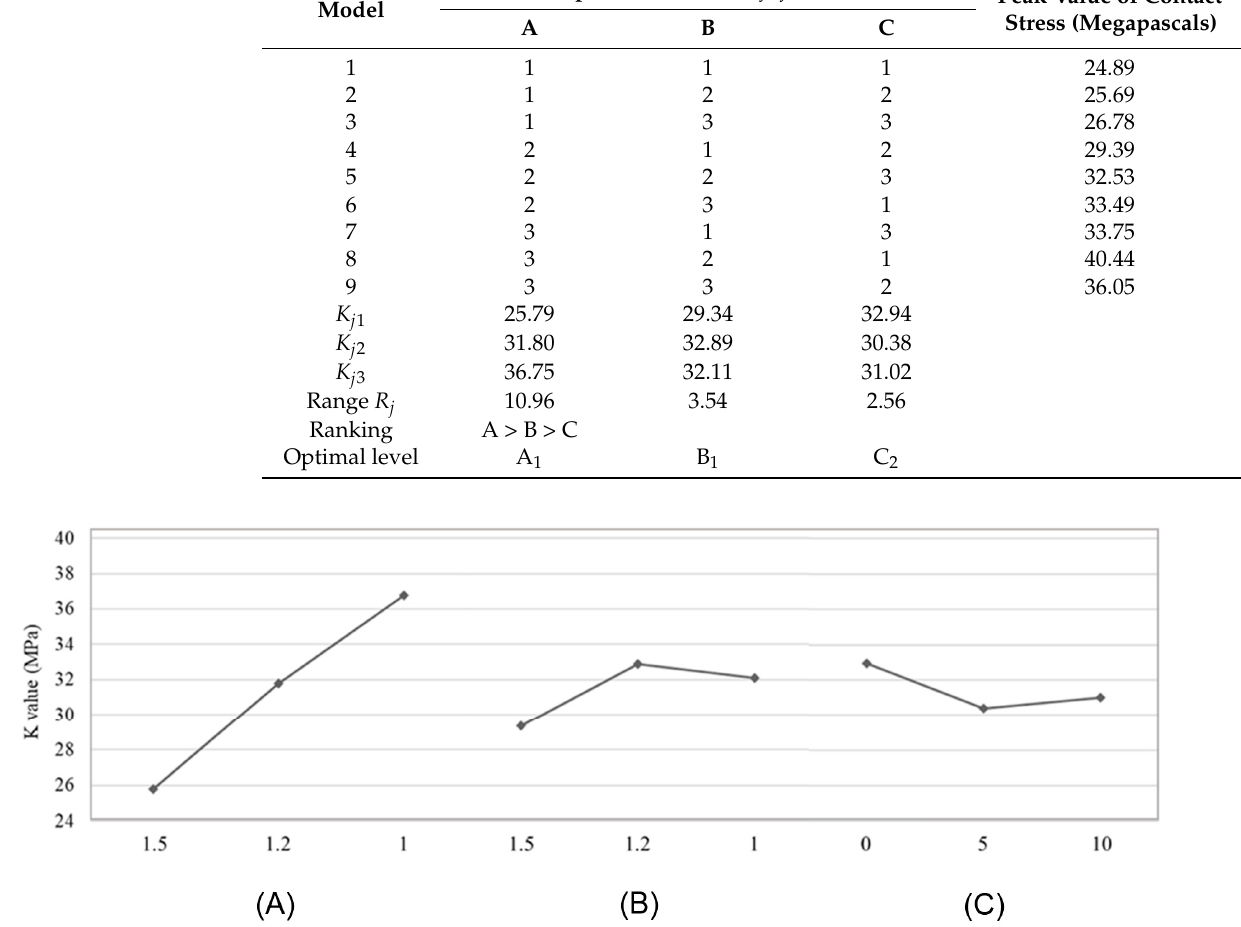
Figure 5. Trend influence of implant design parameters at the peak value of the contact stress on the UHMWPE tibial insert. ( A ) Curvature ratio in sagittal plane. ( B ) Curvature ratio in coronal plane. ( C ) Tibial slope (°).